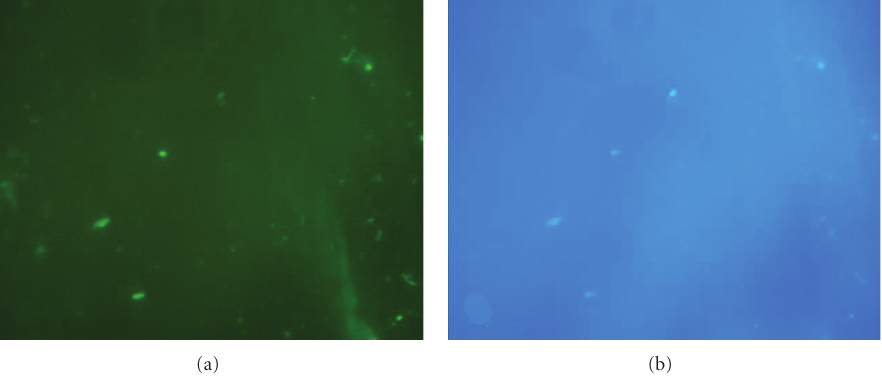
Figure 1: Riskettsial organisms in recently drained CSF; (a) stained with anti-rickettsial antiserum and Alexa Fluor 488 goat anti-rabbit immunoglobulin; (b) the same field of view shows the organisms DNA stained with DAPI in the same